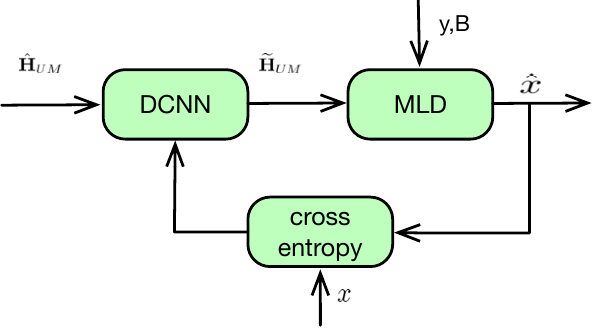
Figure 4. DCNN type-II: Training model of CNN without accurate